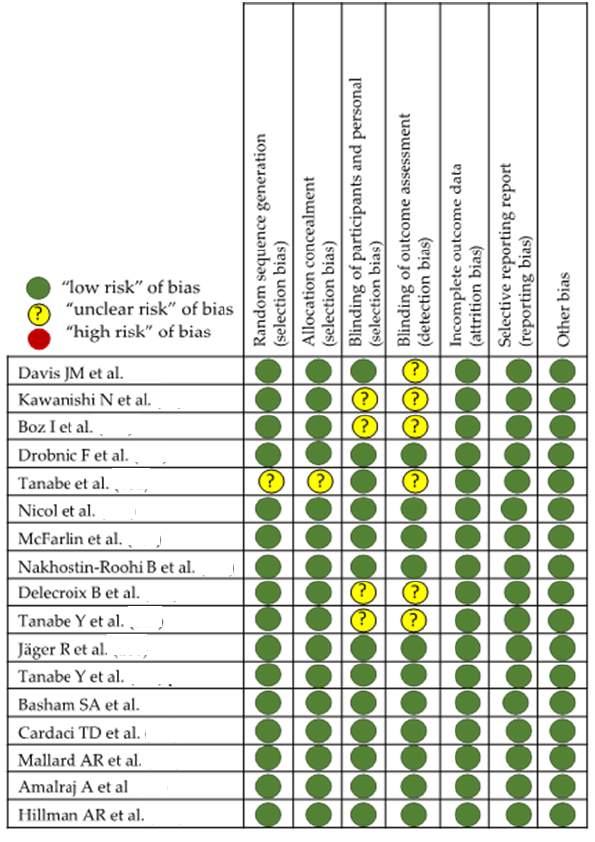
Figure 4. Effect of curcumin on MTJ eccentric injury. [98–115] The type of molecule and whether or not there is a commercial brand, is exposed in the column “Molecule” and the administered curcumin dosage, and the route is indicated in the proper columns “dosage” and “route”. In the Tables, within the corresponding col- umn, it is indicated whether the study had a control group and a placebo group or not. The number and type of subjects included in the study are shown in the “n and Type of subjects” column. The next two columns are related to the type of injury evaluated and the tests or procedures to study the effect. Finally, the last column exposes the “Impact on resolution” of the injury. The two upper studies [88,94] are in vitro and show a better modulation of the inflammatory and degradative processes enhancing the down-regula- tion of the collagen. Rodent studies [89–91,95–97] conclude that curcumin seems to pro- mote tendon-to-bone healing associated with anti-inflammatory and antioxidation effects, with a better functional recovery. Finally, the human studies [92,93] related to surgery procedures include a better pain score, concomitant with the usual treatment, and patient satisfaction. In relation to Tables 1 and 2, which evaluate the effect of the use of curcumin against DOMS in the MTJ, due to eccentric work, a lower presence of pain perception and lower creatine kinase (CK) values seem a common result, although there are those that do not observe changes [98–115]. The studies that determine cytokines are not conclusive and show diverse results, being better described in [101,103,104,110], although it is necessary to point out that no changes in TNF- α were reported in [102,103,110,113], while positive changes reported in [98,104,111]. When evaluating the possible effect of curcumin on the injury response of an eccen- tric work such as DOMS in MTJ, we pleasantly observed that randomization and double- blinding are present in almost all of them. It is assumed that the statistical study and the evaluation of the results remain with the double-blind method until the discussion begins once the study arms are identified. However, there are three of them, in this group of studies with rodents [98–100], in which the presence of double blinding is not feasible and